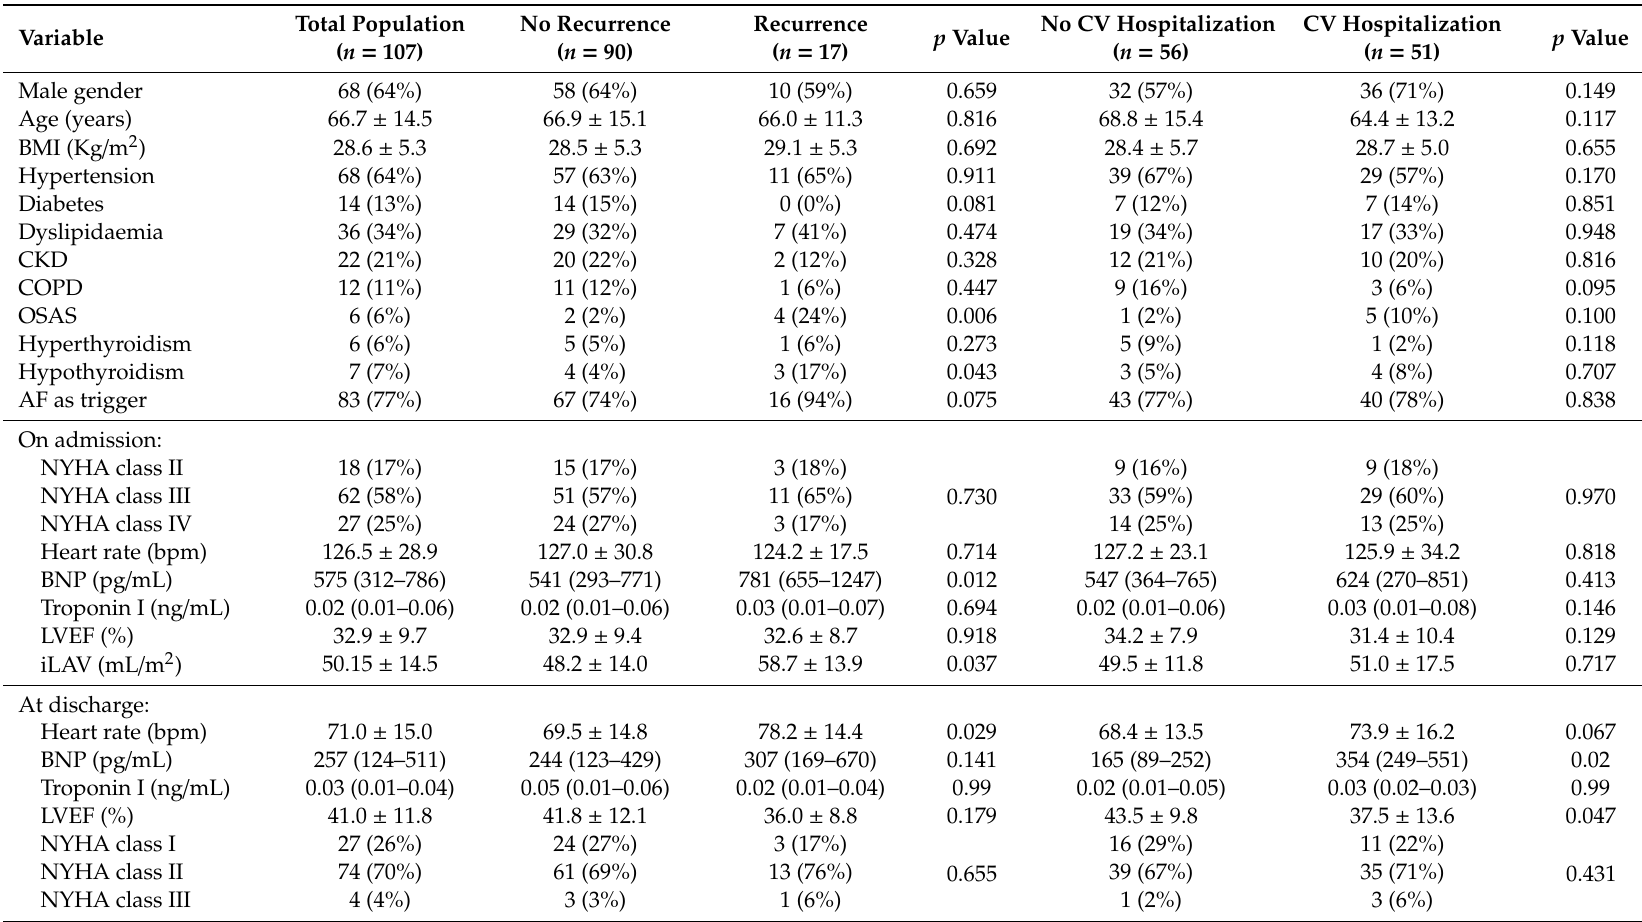
Table 1. Baseline characteristics, also divided by the incidence of tachycardiomyopathy recurrence and cardiovascular-related